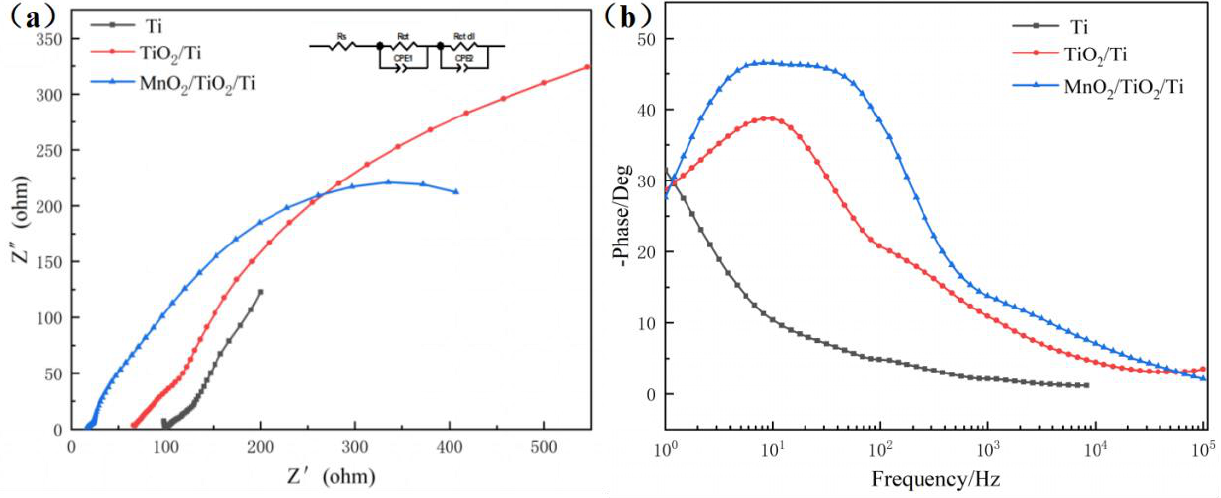
Table 2. Results of the EIS fitting texts of the porous Ti, surface-modified TiO 2 /Ti, and MnO 2 /TiO 2 /Ti nano composites.